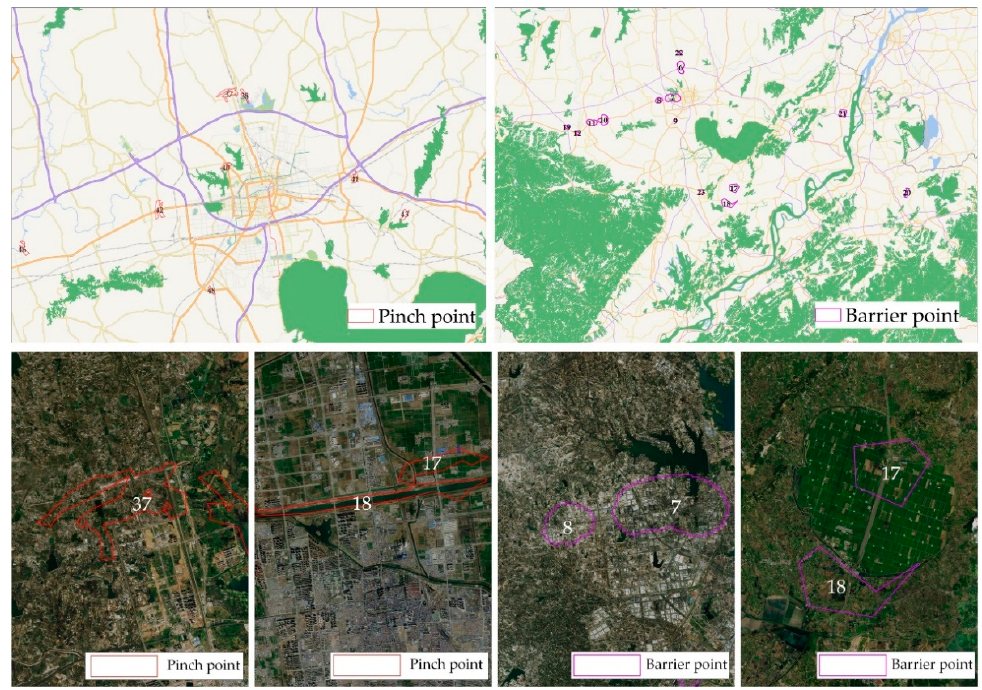
Figure 9. Examples of land use composition of pinch points and barrier points.